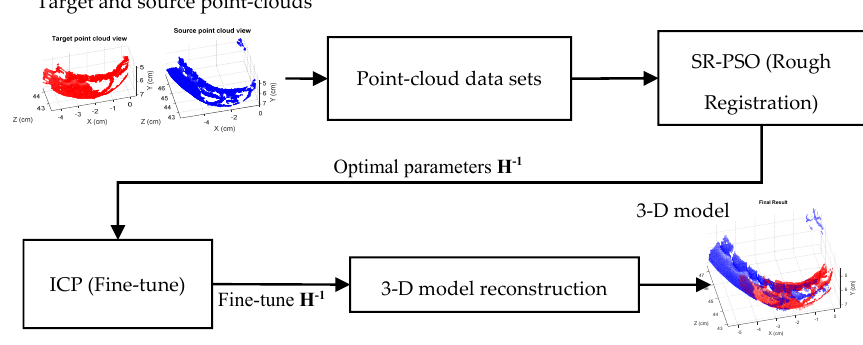
Figure 1. Diagram of the proposed 3-D tooth model reconstruction system. To test the algorithm, we ran the experiment of the generated original shape and its 3-D transformation as shown in Figure 2.